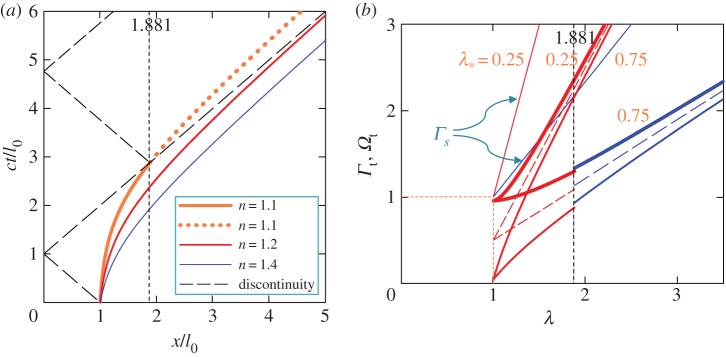
(a) Arrival time (equation (4.4)), τ=ct/l0, of the band tip at ξ=x/l0 for λ*=0.75 and n=1.4 (thin, blue line), n=1.2 (red line of medium thickness), and n=1.1 (bold, orange line). (b) Strain, Γt=−γt/γ0, and slip rate, Ωt=ηt/(cγ0), at the band tip (solid lines, bold and of intermediate thickness, respectively) versus band length, λ=l/l0. Γt and Ωt are plotted before (solid, red lines) and after (solid, blue lines) the discontinuity arrives at the tip for n=1.1 and λ*=0.25 (red lines) and 0.75 (red and blue lines). Thin, solid, red and blue lines show the static strain, Γs=−γs/γ0, for these values of λ*, respectively. Dashed lines show asymptotes of Γt and Ωt at λ→∞.